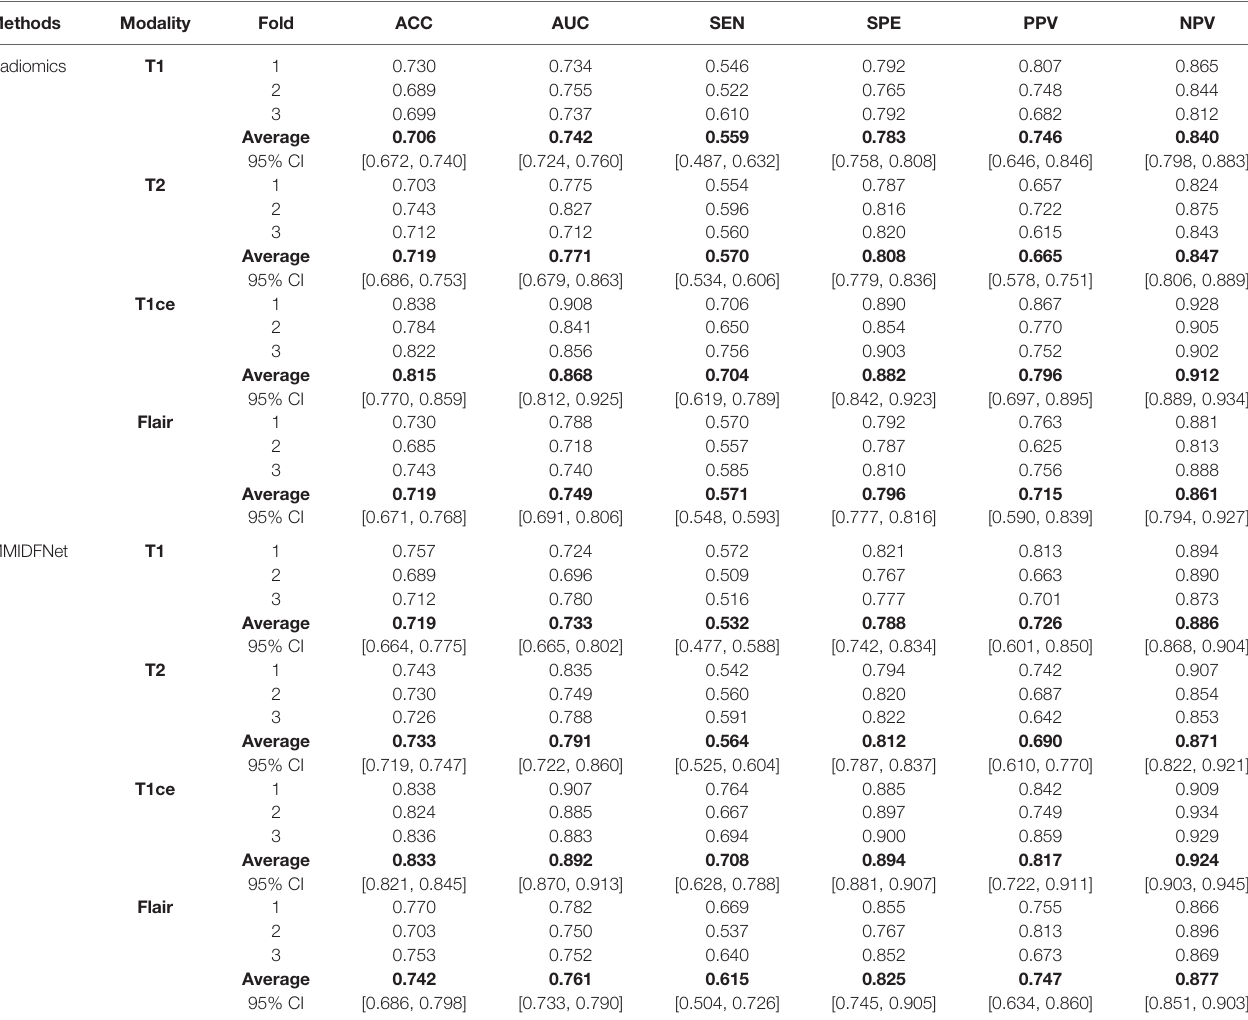
TABLE 1 | Three-fold cross-validation performance of unimodal prediction models using radiomics and our proposed MMIDFNet.